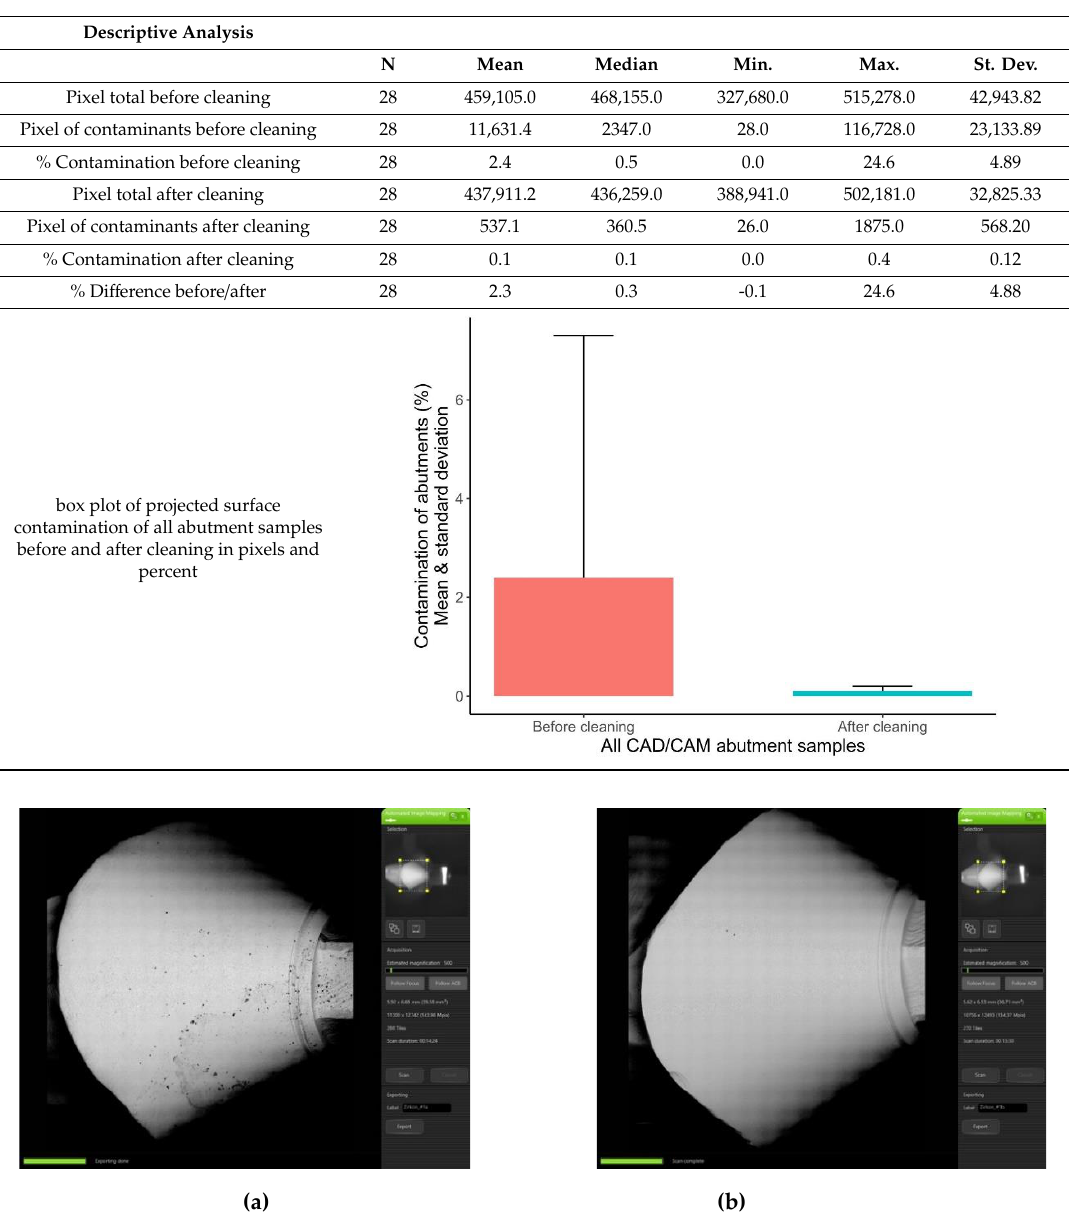
Table 6. Descriptive analysis; box plot of projected surface contamination of all abutment samples before and after cleaning in pixels and percent.